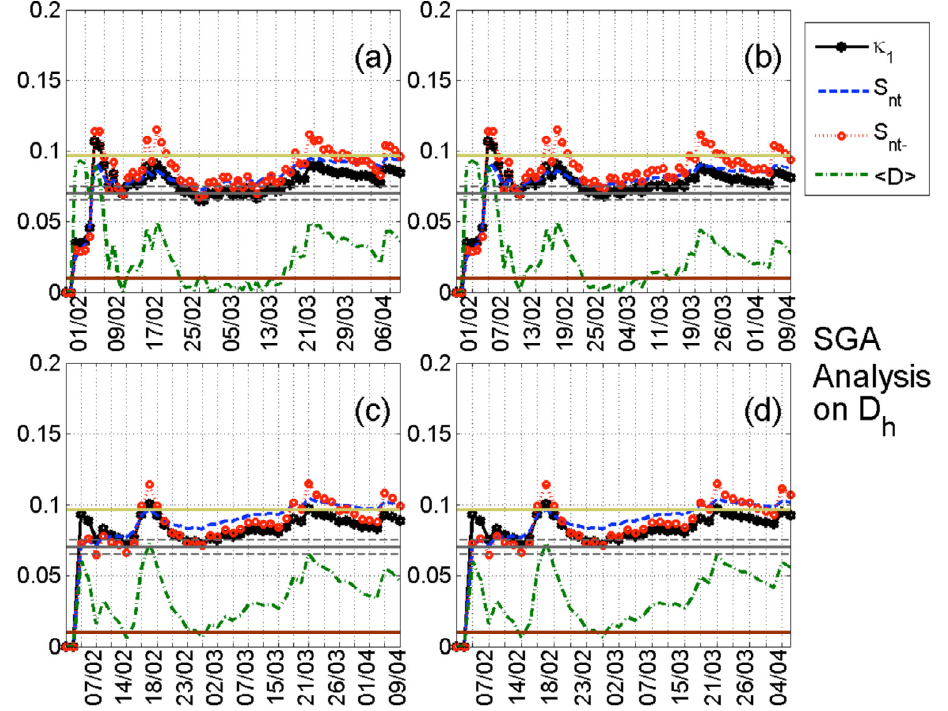
at SGA for the time period from February 1 to April 12, h 0, 50, 150, and 200, respectively. Note that h,thres